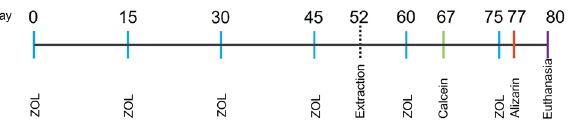
Figure 1. Flowchart of the work phases for mineralized tissue analysis, mentioned in days. (Blue lines, ZOL application; dotted line, extraction, and treatment of alveolus; green line, calcein application; red line, alizarin application; purple line, euthanasia, and collection of right